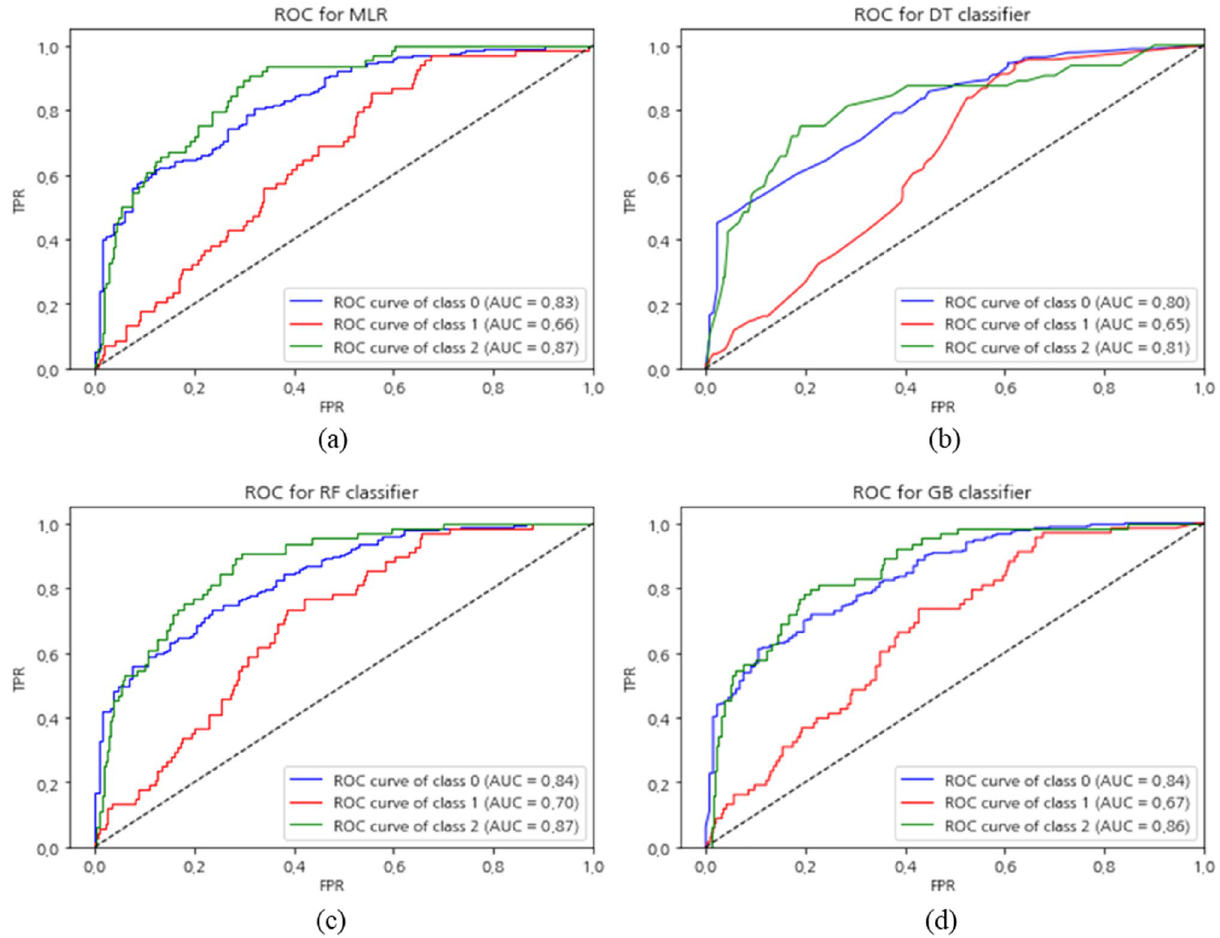
Figure 6. AUC–ROC: ( a ) MLR, ( b ) DT classifier, ( c ) RF classifier, ( d ) GB